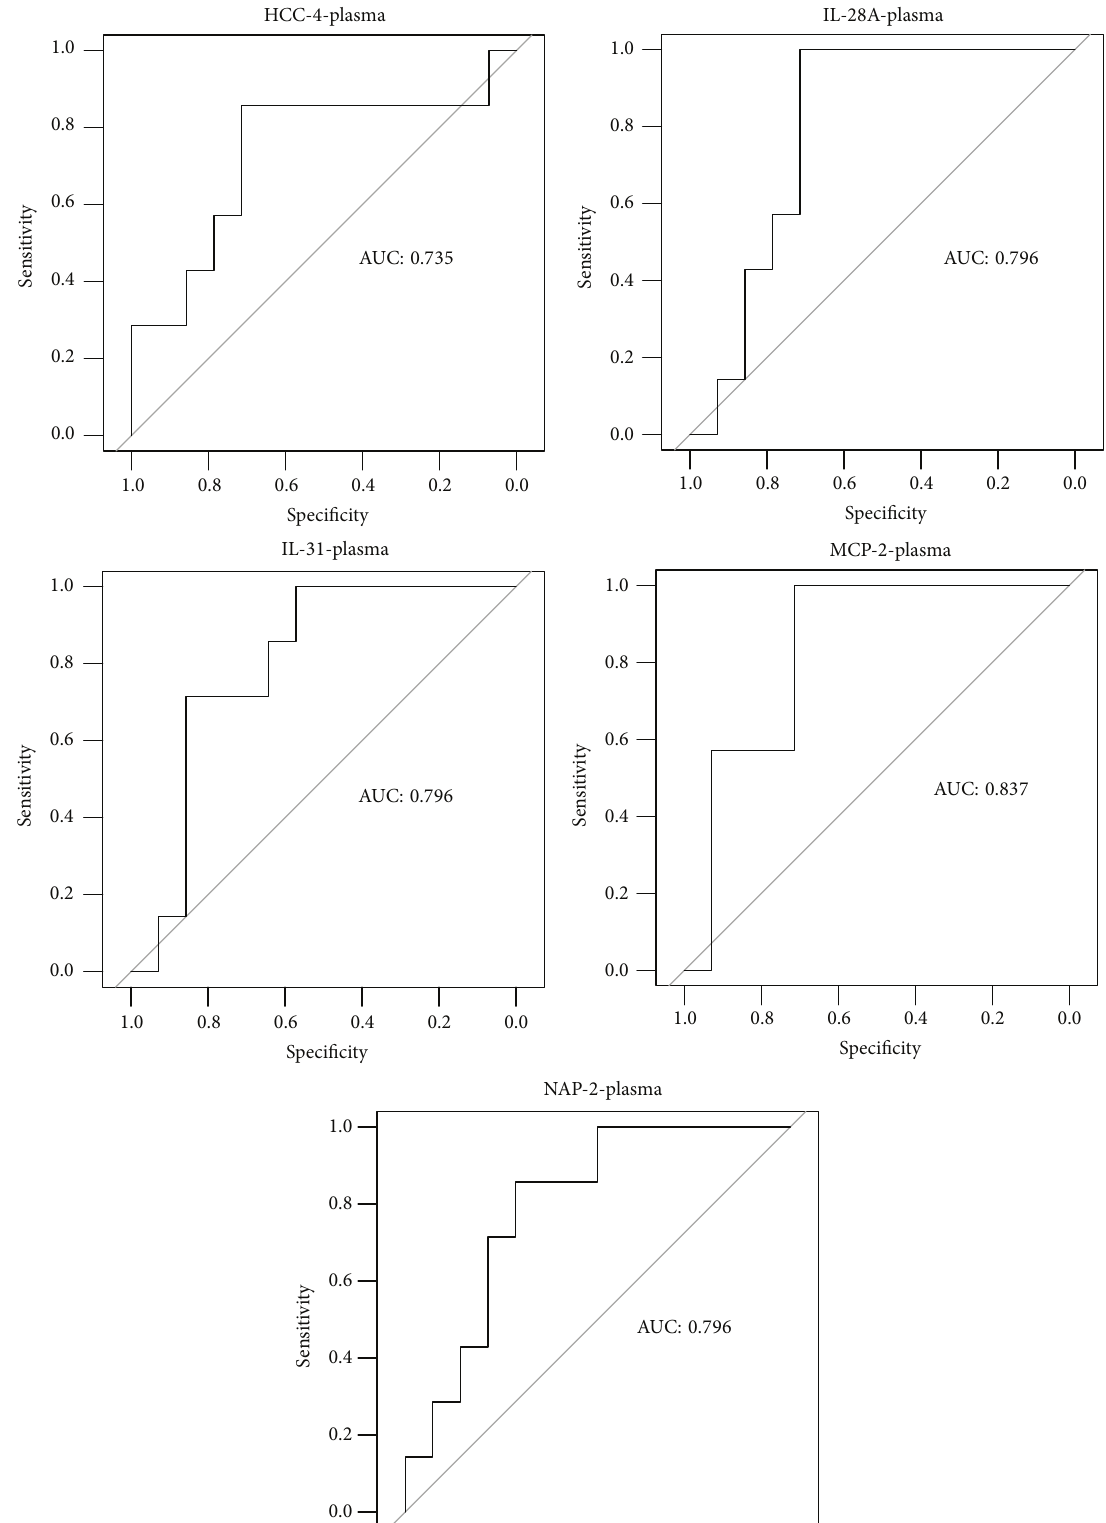
Figure 1: The ROC curves for concentration of chemokines in plasma: HCC-4, IL-28A, IL-31, MCP-2, and NAP-2